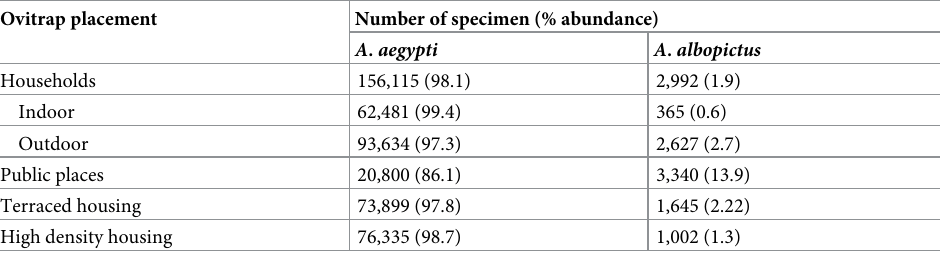
Table 1. Number and percentage abundance of dengue vector mosquitoes that hatched from eggs collected from various ovitrap